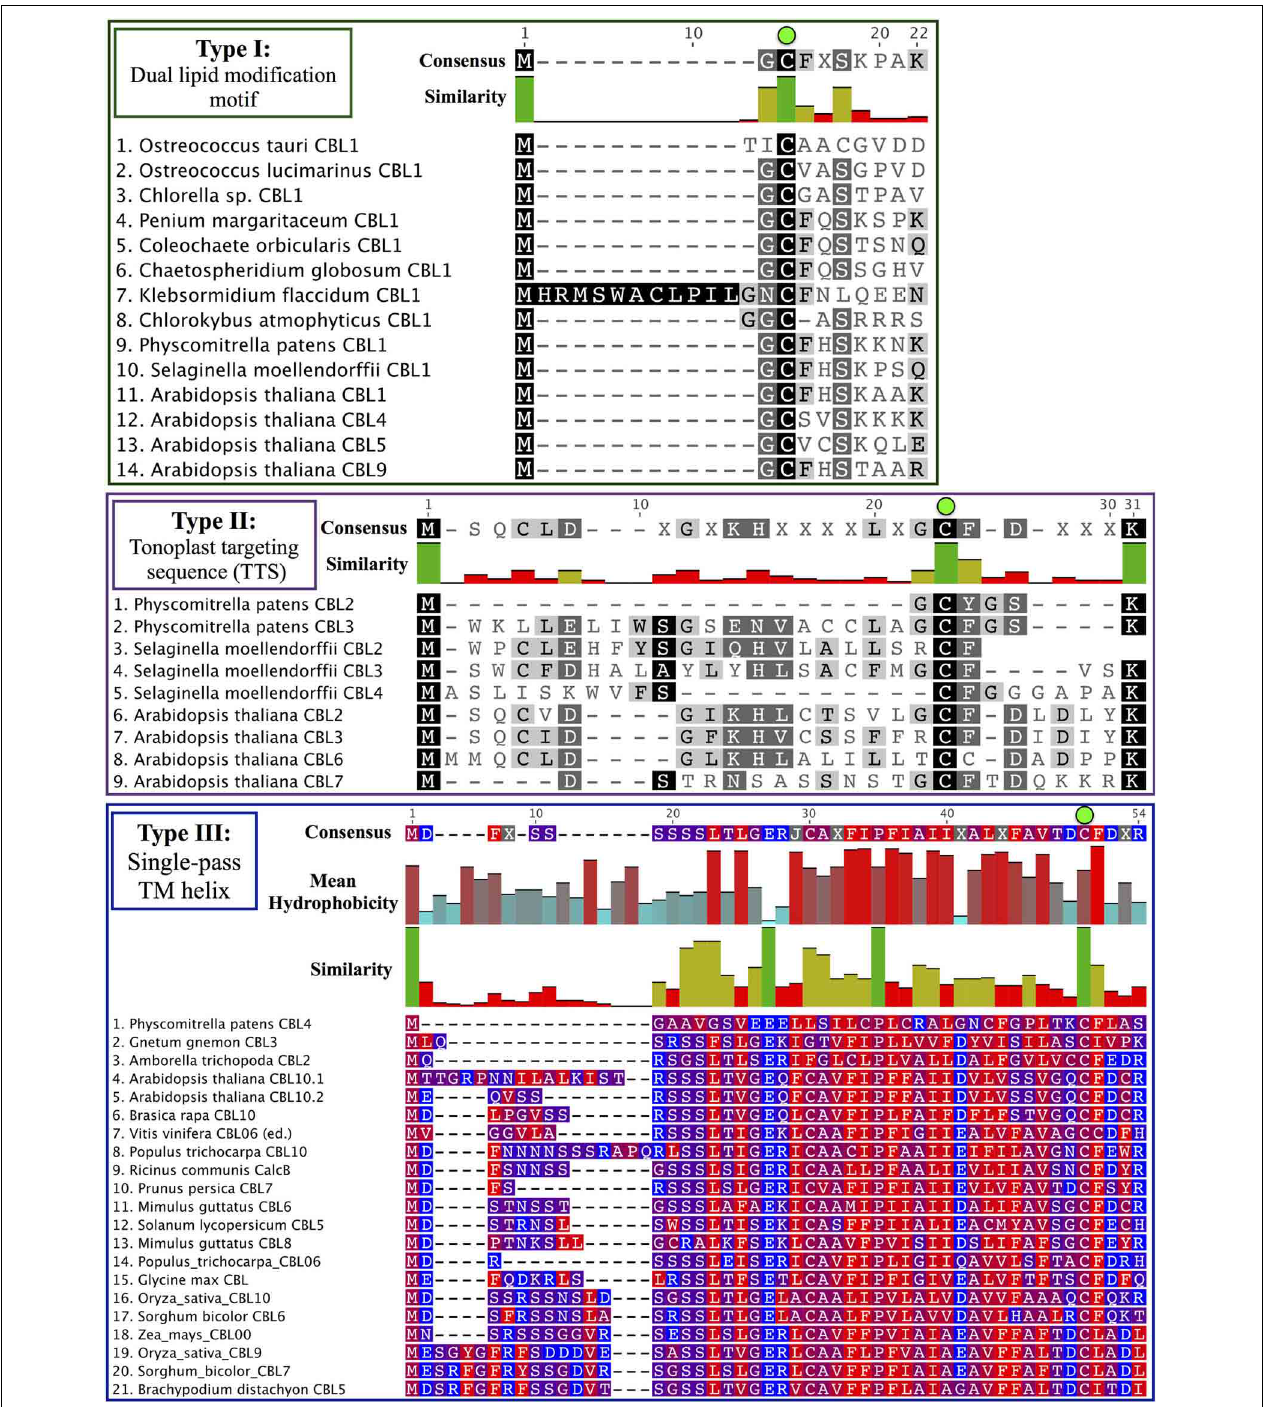
FIGURE 3 | CBL N-terminal localization motifs can be classified into three ancient types. Consensus sequences are provided above each MSA, and degree of conservation is indicated by bar graph and shading. Note the strictly conserved cysteine residues (green dots) in all three types of CBLs. (Top) Type I CBLs harbor a dual-lipid modification motif (MGCXXS/T) that triggers N-myristoylation of the glycine residue and S-acylation of the cysteine residue. Most green algal CBLs identified to date are Type I CBLs or appear to retain signatures of the dual-lipid modification motif. (Middle) Type II CBLs are characterized by a N-terminal extension called the TTS that is